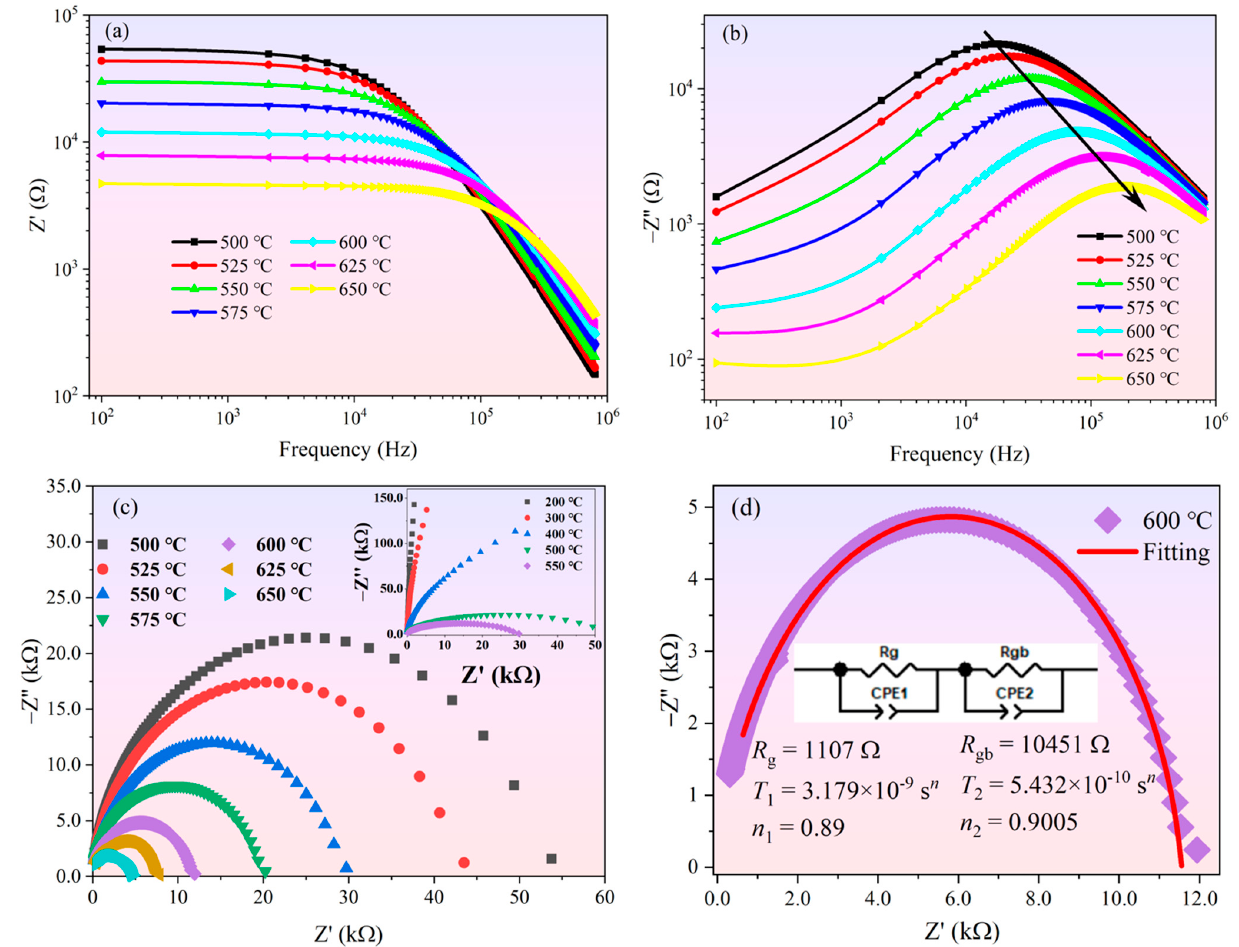
Figure 5. Electrical impedance spectroscopy of the BGTN − 0.2Cr ceramic at high temperature: ( a ) Z (cid:48) ; ( b ) − Z (cid:48)(cid:48) ; ( c ) − Z (cid:48)(cid:48) vs. Z (cid:48) (inset shows the impedance curve measured below 550 ◦ C); ( d ) fitting for the Nyquist plot at 600 ◦ C. The Nyquist plot ( Z (cid:48)(cid:48) vs. Z (cid:48) ) from 200 to 650 ◦ C is shown in Figure 5c. The